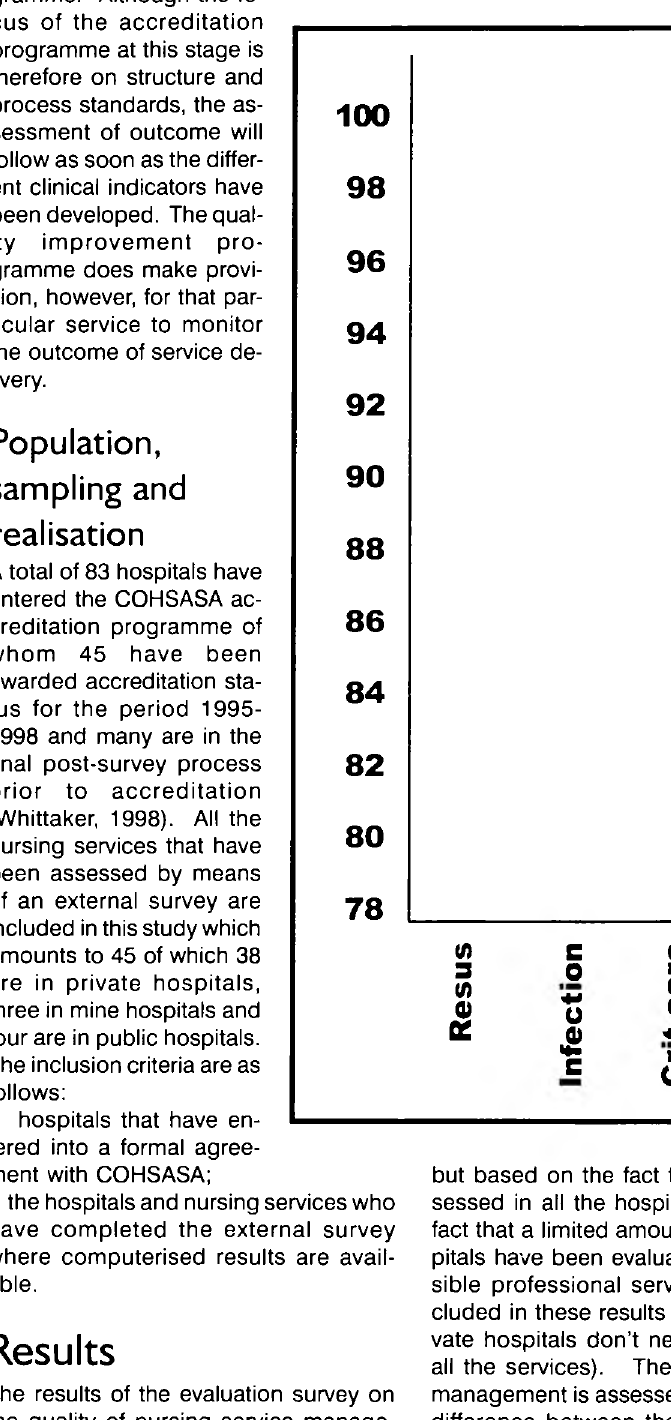
Table 1 : Com parison b etw een th e baselin e